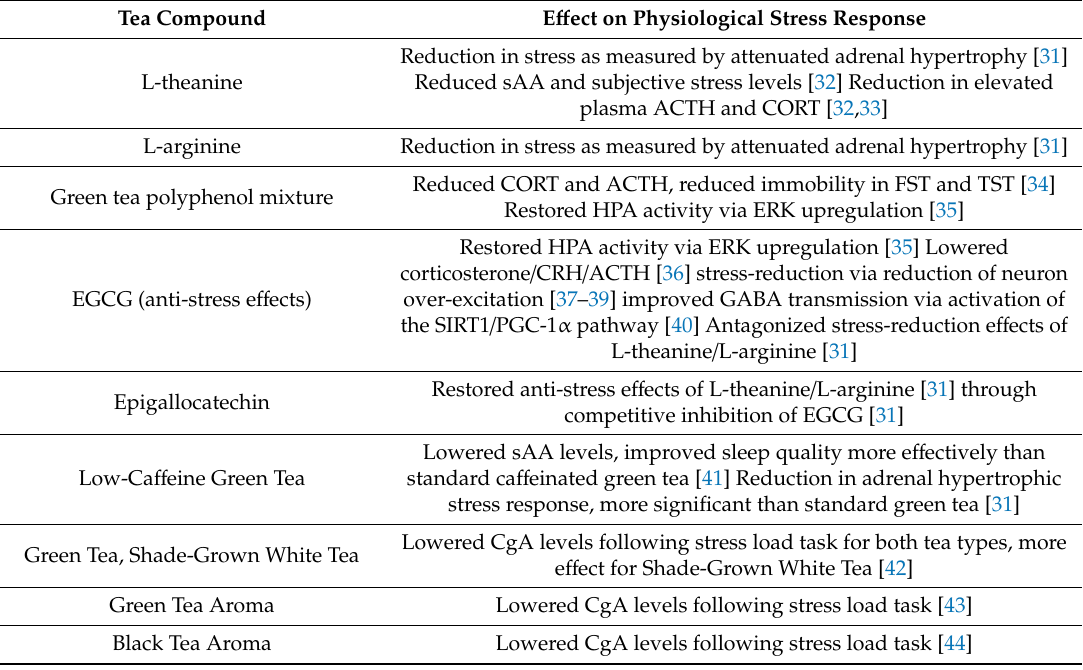
Figure 2. The positive feedback loop of chronic stress and inflammation. Dysregulated HPA axis and chronic inflammation represent two mechanistic nodes within an interrelated system of depression pathology. Bullet points represent signaling pathways and pathological targets for tea phytochemicals. Green lines represent attenuating e ff ect, while red lines represent exacerbating e ff ect. HPA, hypothalamic–pituitary–adrenal; CRH, corticotropin-releasing hormone; ACTH, adrenocorticotropin hormone; MCP-1, monocyte chemoattractant protein-1. Table 1. Tea compounds and their e ff ects on physiological